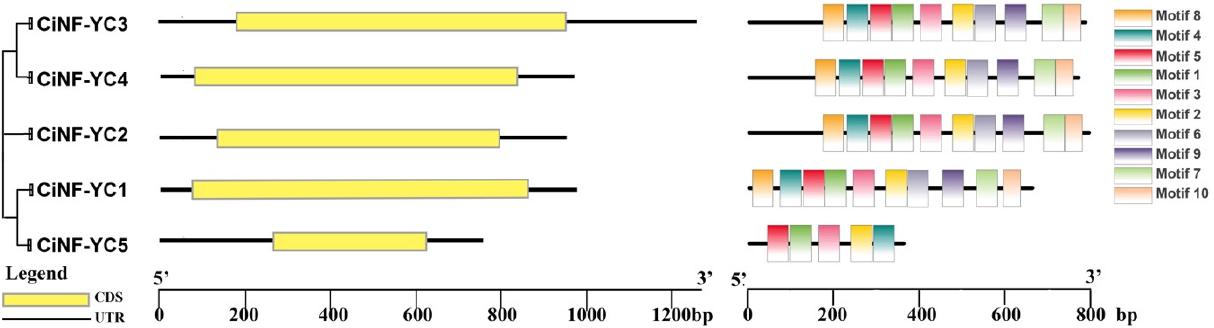
Figure 2. The exon-intron structure and conserved motifs of NF-YC ORF region in wild chrysanthe- mums. Exons and UTRs are indicated with yellow rectangles and black lines, respectively. Each conserved motif is represented by a number of colored rectangles. Box length corresponds to motif